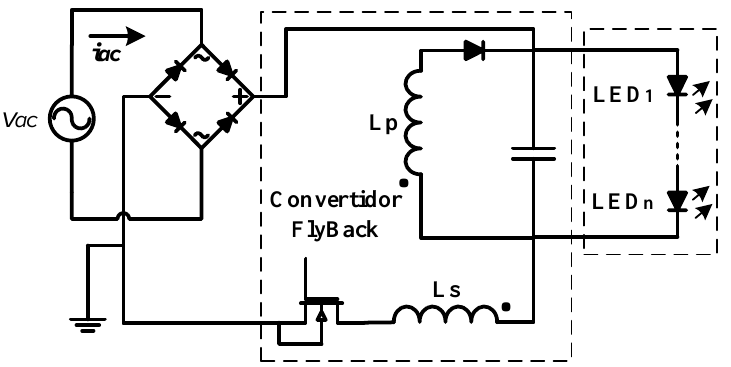
Figure 1. Proposed topology: Rearranged flyback converter, with primary and secondary in series.